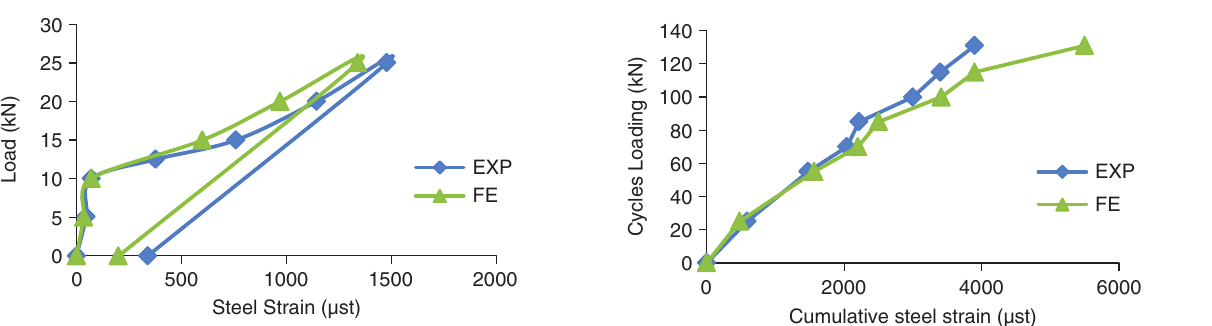
Fig. 14. Load against the cumulative steel strain for post-repair phase of the beam G2R1